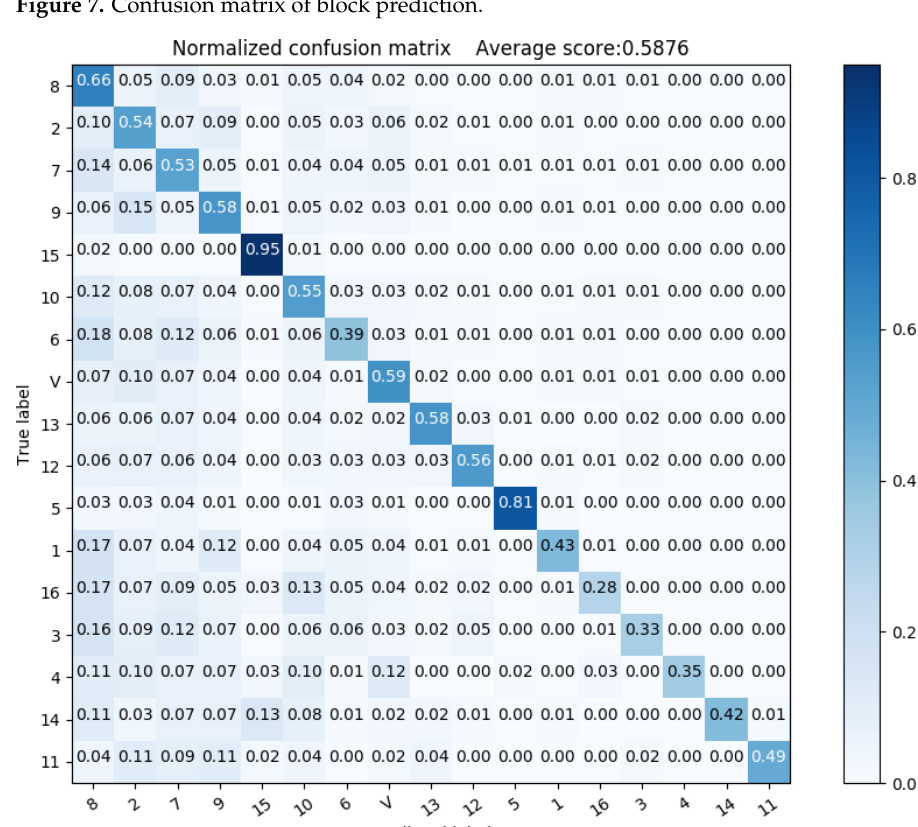
Figure 7. Confusion matrix of block prediction.